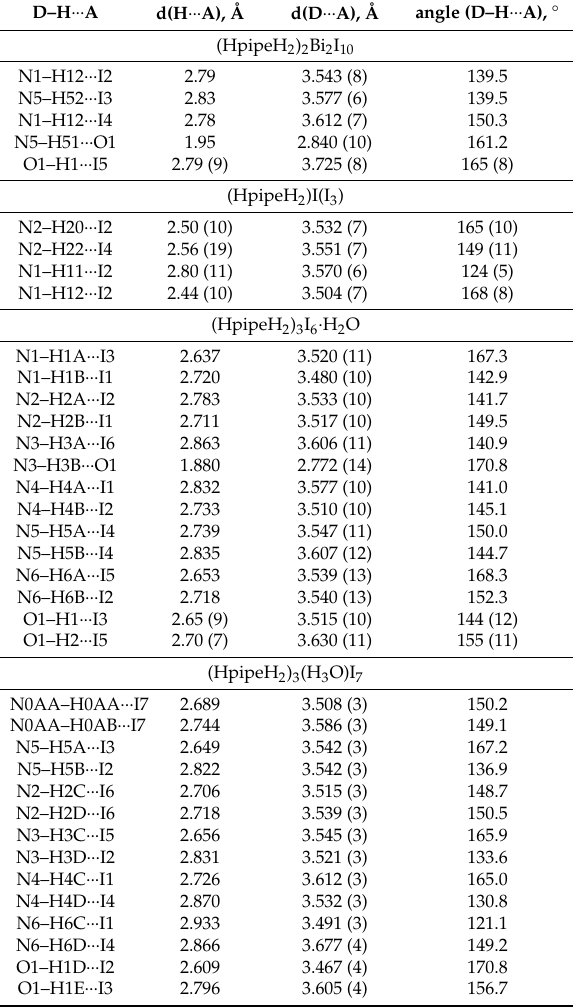
Table 3. Hydrogen Bonding in the Crystal